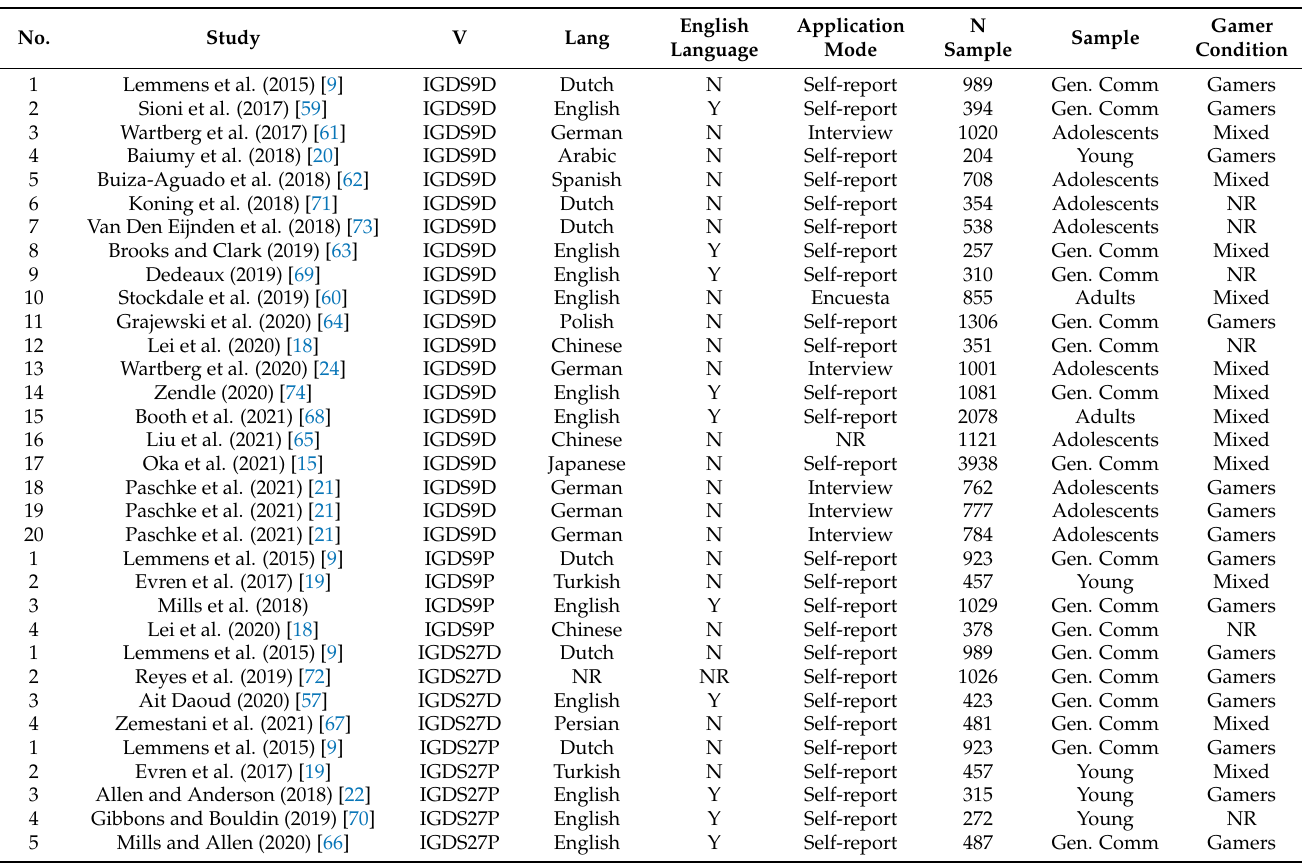
Table A3. Characteristics of the selected studies (frequency